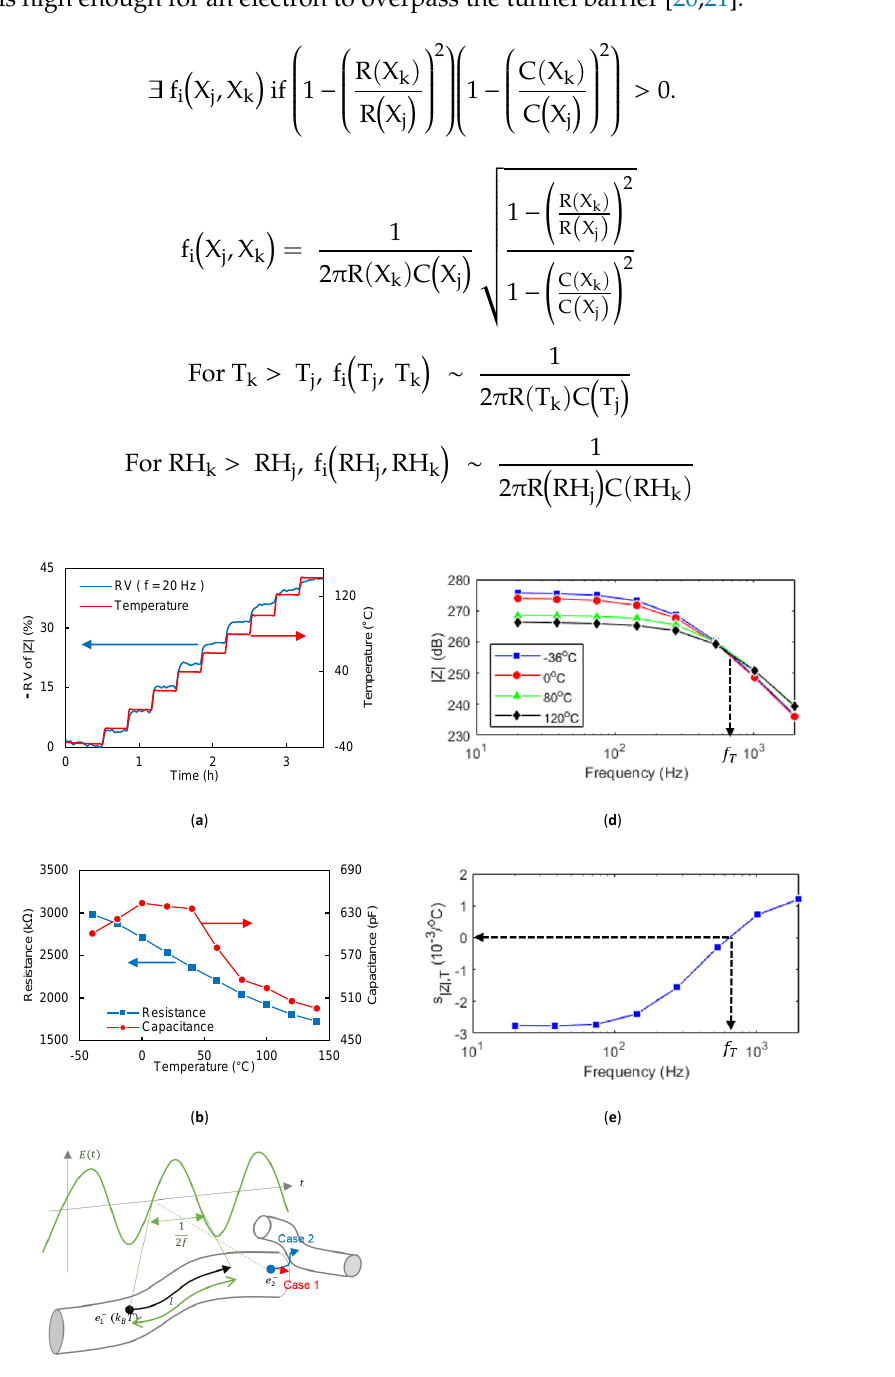
Figure 2. Thermoelectric effect. ( a ) Real-time low-frequency impedance magnitude-time curve during temperature cycles. ( b ) Electrical properties of multiwall carbon nanotube (MWCNT) network of different temperatures. ( c ) Multiscale schematic diagram of the sensing mechanism of the sensor with temperature changes. ( d ) Impedance magnitude of sensor of different temperatures and frequencies. ( e ) Impedance magnitude sensitivity to temperature of different frequencies.